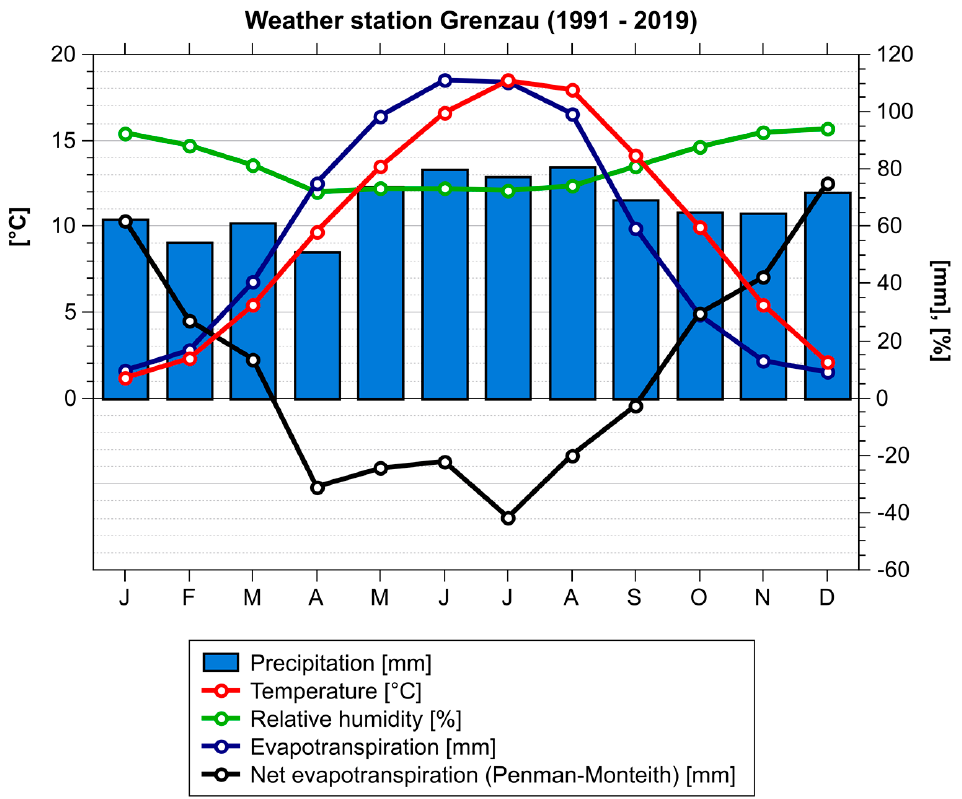
Figure 4. Climograph for weather station Grenzau, raw data collected by the Dienstleistungszentrum Ländlicher Raum Rhineland-Palatinate. Table 1. Climate data used for Water Erosion Prediction Project (WEPP) modeling, excerpt from CLIGEN parameter